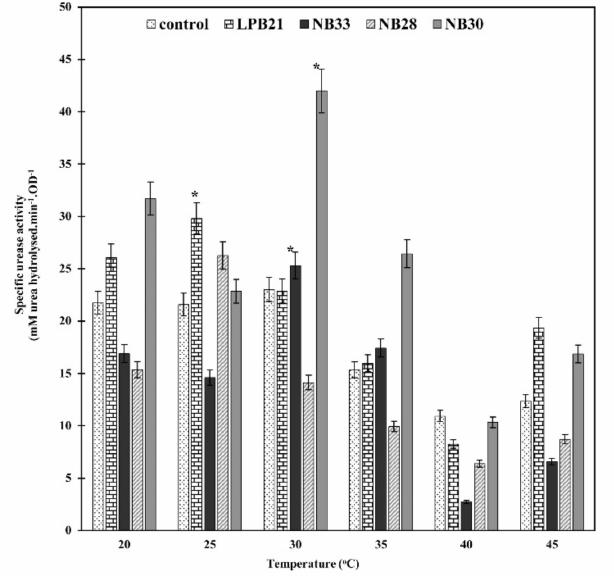
Figure 13. Effect of temperature on urease activity of urease-producing bacteria. Control: S. pasteurii DSM 33; LPB21: closest match Sporosarcina pasteurii fwzy14; NB33: closest match Sporosarcina pasteurii WJ-4; NB28: closest match Sporosarcina pasteurii WJ-5; NB30: closest match Sporosarcina pasteurii fwzy14. Significance level was set to 0.05 (*)